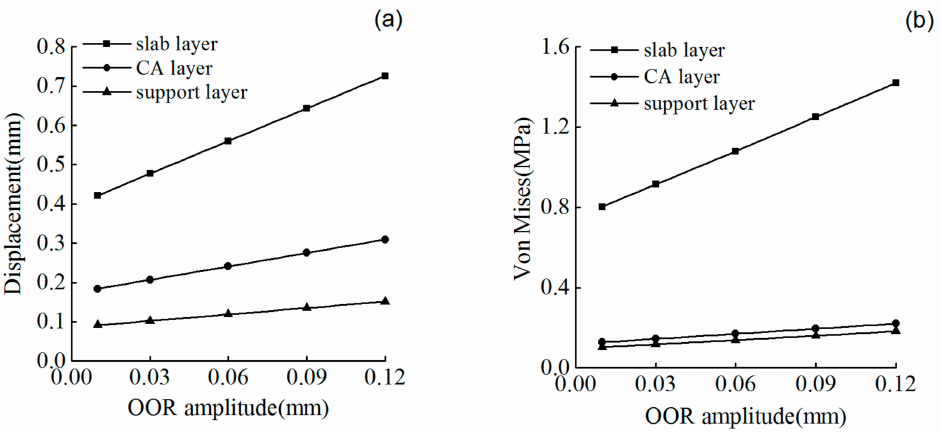
E ff ects of OOR amplitude on dynamics in rail-supporting structural components: ( a ) displacement and ( b ) von Mises equivalent